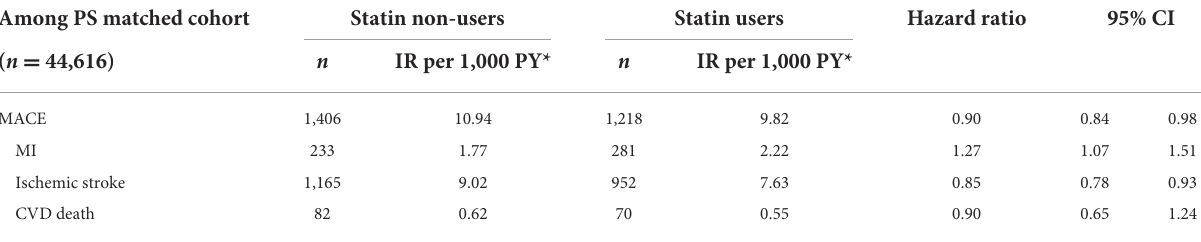
TABLE 2 Incidence and hazard ratio of